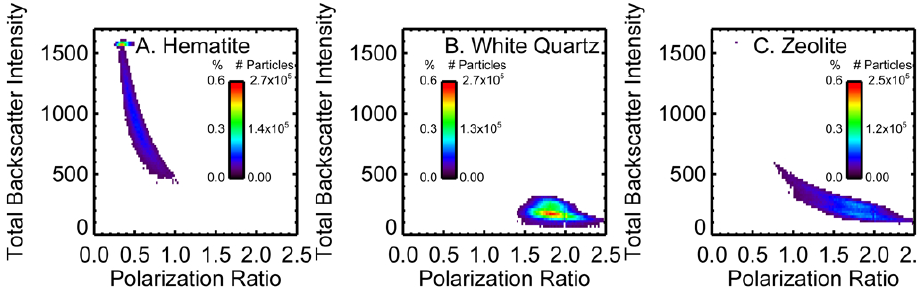
Fig. 9. Total backscatter intensity vs. polarization ratio for representative members of the optical scattering Groups A (hematite), B (white quartz) and C (zeolite) are shown.